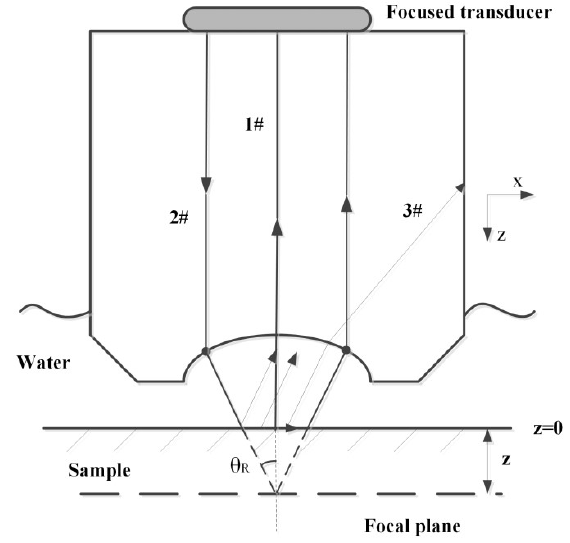
Figure 1. The schematic description of the focused acoustic beam.